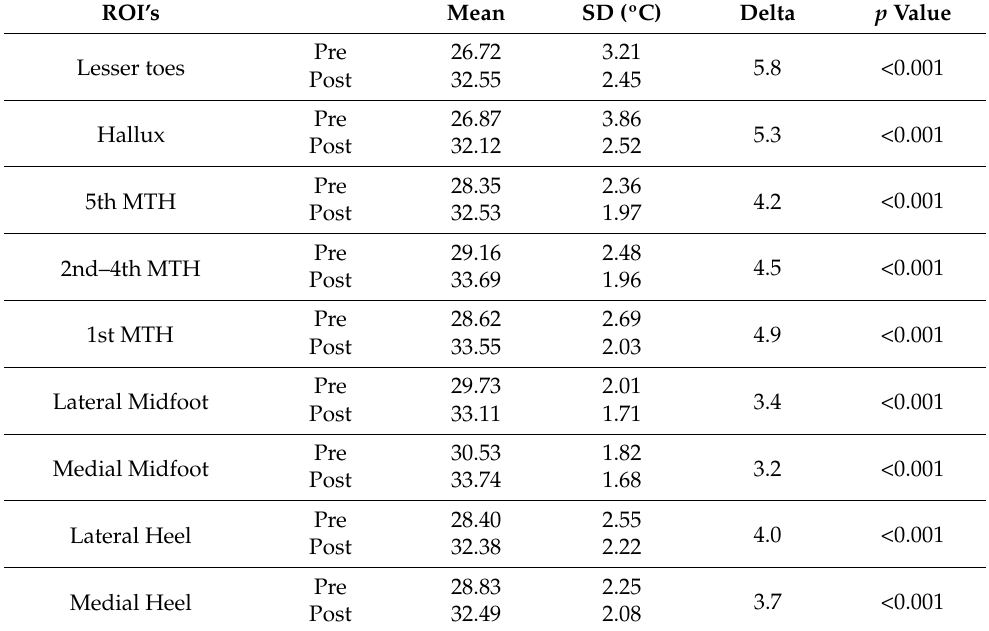
Table 3. Pre- and post-exercise temperatures when using the AWC 2.1 model sock.